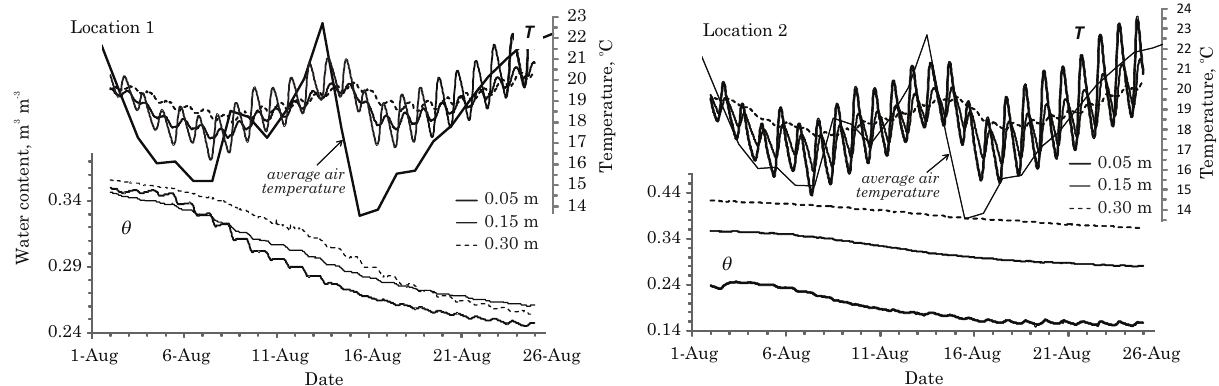
Figure 1. Observed soil water content and soil temperature at two Locations (three depths per Location) during the experimental period in 2010.